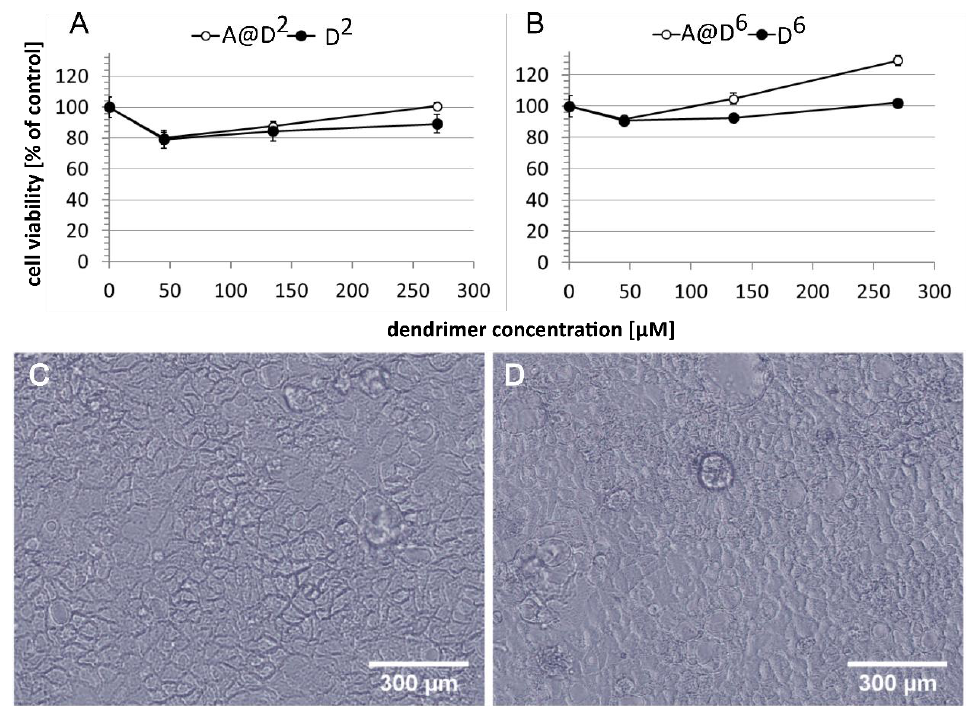
Figure 5. Viability of Caco-2 cells after treatment with aqueous solutions of encapsulates and dendrimer conjugates: ( A ) A@D 2 , D 2 and ( B ) A@D 6 , D 6 at concentrations of 45, 135, and 270 µM. Data are presented as means ± SD normalized to untreated control. Images of Caco-2 cells: ( C ) Control and ( D ) incubated with D 2 at concentration of 270 µM.